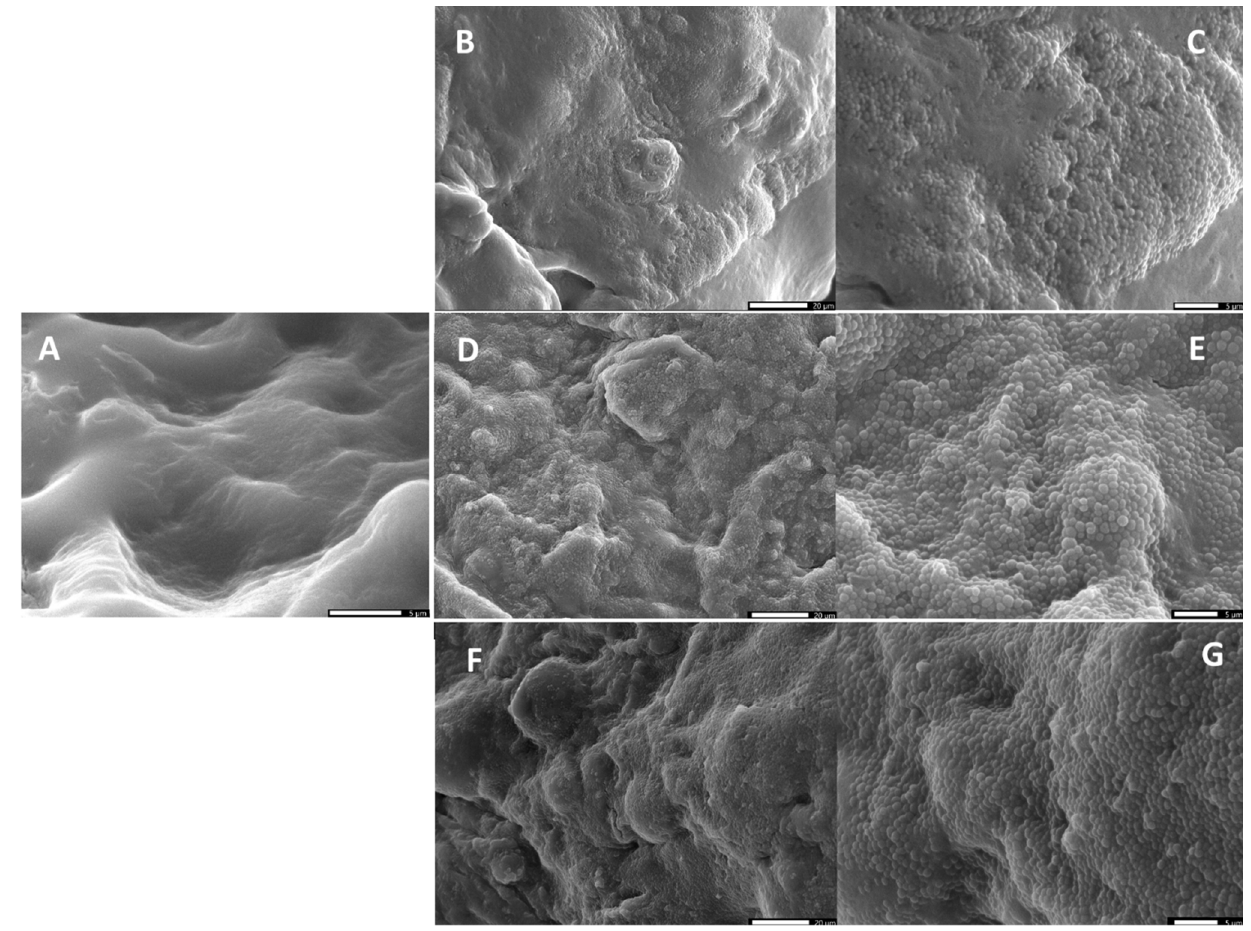
Figure 3. SEM microscopy of blank sample ( A ) and biofilms of S. epidermidis ( B , C ), S. aureus 209 P ( D , E ), M. luteus C01 ( F , G ) on the surface of the pellets. Magnification is 900× ( B , D , F ) scale bar indicates 20 μm and 2700× ( A , C , E , G ) scale bar indicates 5 μm.